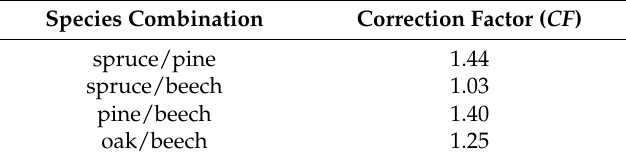
Table 1. Correction factors for species combinations of four tree species (values resulting from evaluations in the context of [30], see Appendix A). European beech, Norway spruce, Scots pine and sessile